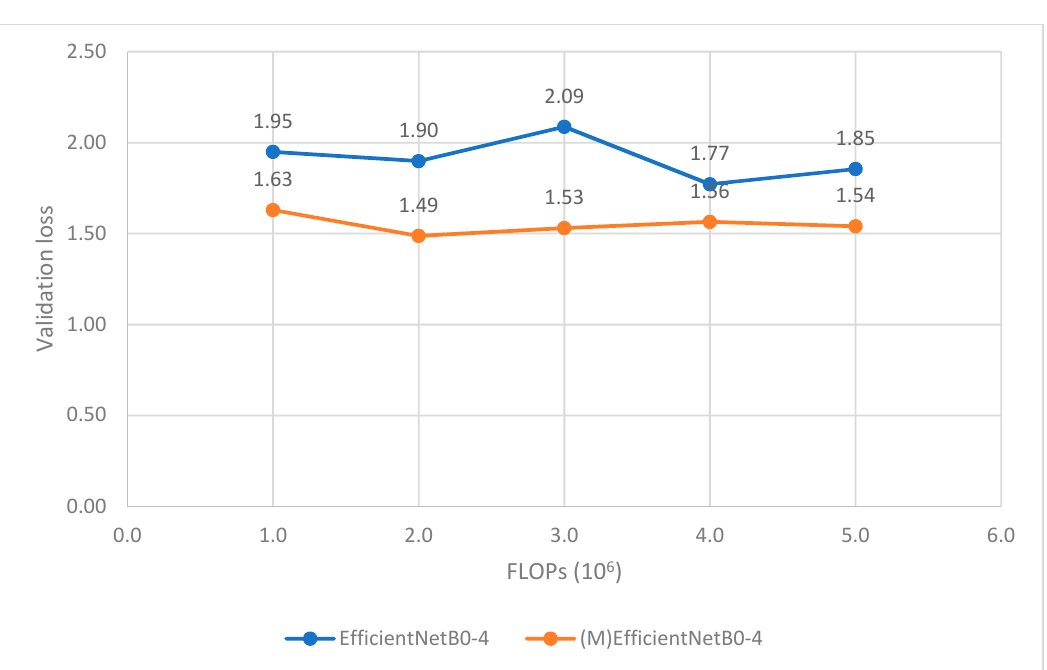
Figure 12 . Comparison between MobileNet and (M) MobileNet (V1–V3, right to left, respectively).